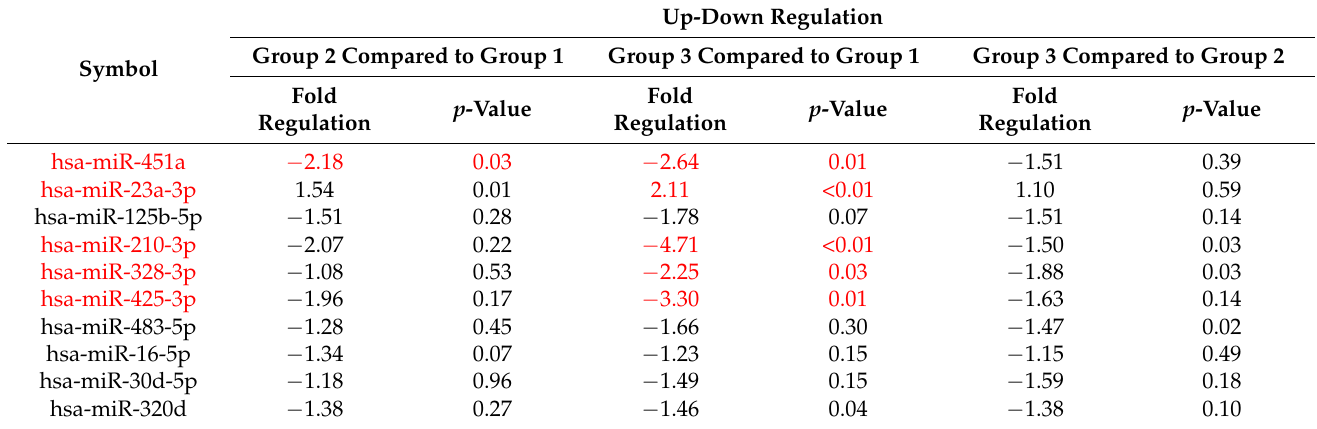
Table 2. Deregulated miRNAs in the circulation of all studied